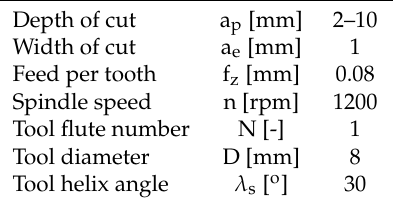
Table 3. Machining conditions of the